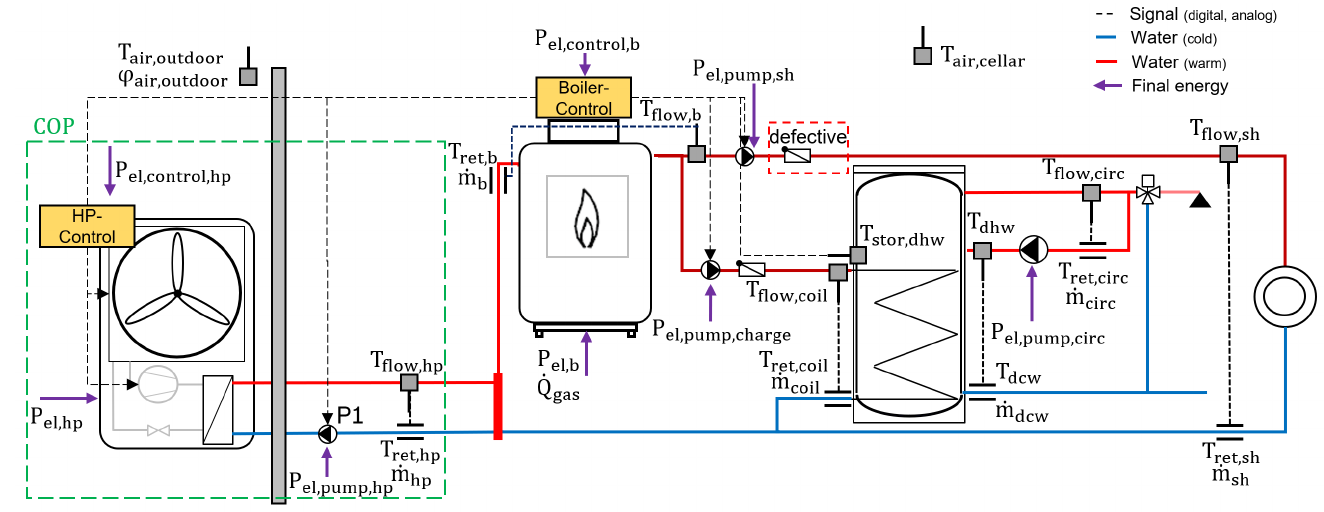
Figure 3. Hydraulic and control schematic of the field trial with measurement positions and defective SH nonreturn